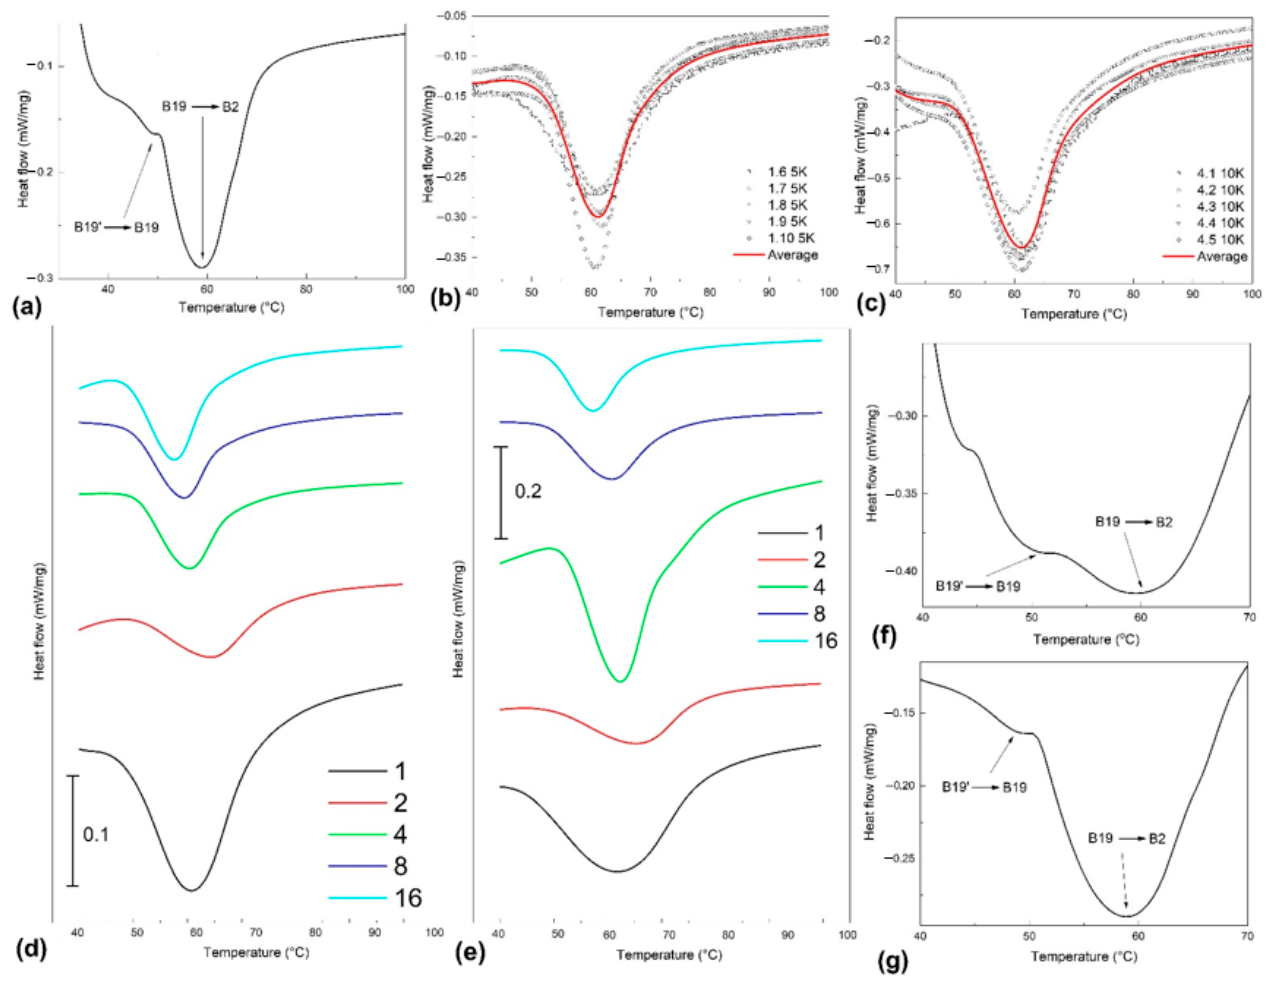
Figure 5. DSC thermograms of fragments cut from specimens trained by FR-SME during up to 16 cycles at different heating rates: ( a ) initial hot-rolled water-quenched state; ( b ) experimental and average heat flow values at a heating rate of 5 ◦ C/min for a specimen trained for 1 cycle; ( c ) experimental and average values at 10 ◦ C/min for a specimen trained for 16 cycles; ( d ) average values for specimens heated at 5 ◦ C/min; ( e ) average values for specimens heated at 10 ◦ C/min; ( f ) detail of average heat flow values for a specimen trained for 8 cycles heated at 1 ◦ C/min; ( g ) detail of average heat flow values for a specimen trained 16 cycles heated at 1 ◦ C/min. Table 2. Variations in specific absorbed enthalpy ( ∆ h endo ) and temperature of reverse transformation peak ( A 50 ) with the number of FR SME training cycles according to the average heat flow variation with temperatures from Figure 5d,e. Cycle